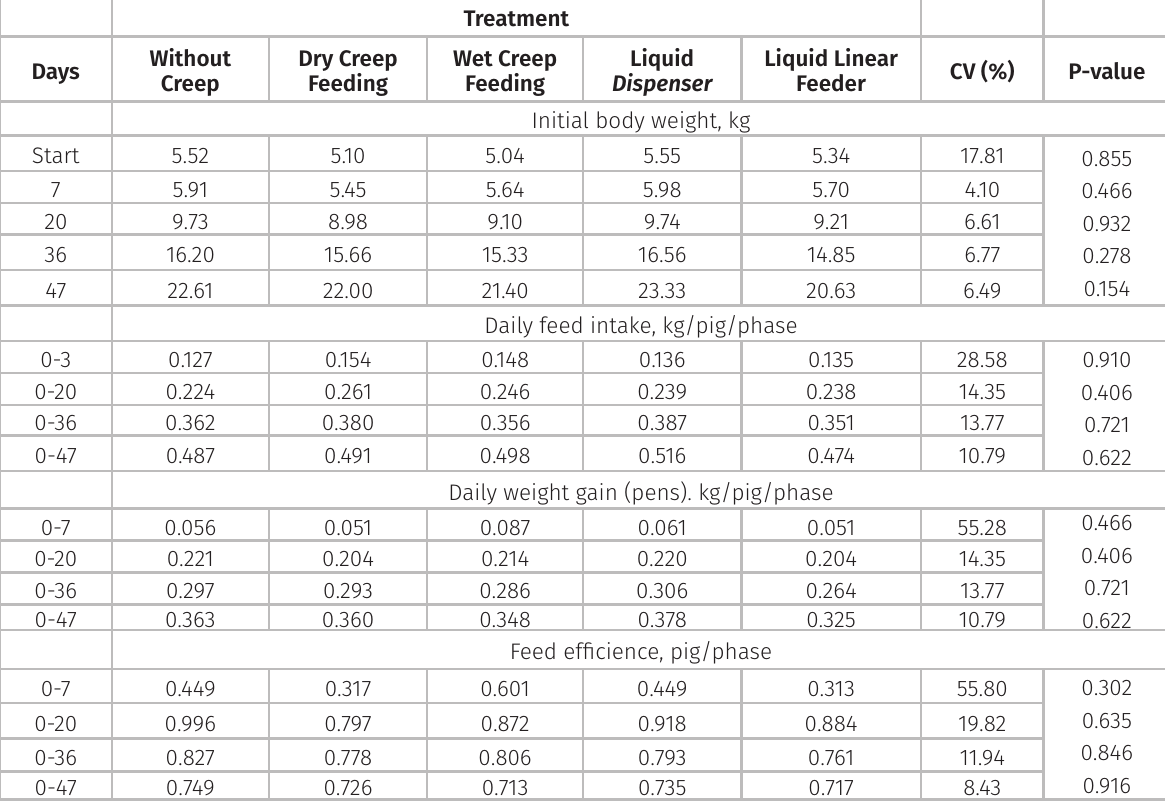
Table IV. Feed intake and feed:gain ratio of piglets in nursery phase under different feed protocols across the suckling